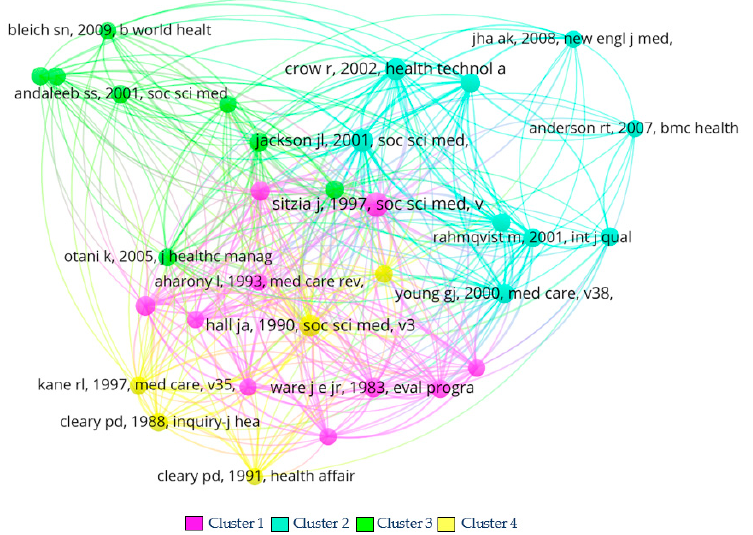
Figure 10. Documents’ co-citation analysis network using VOSviewer software. Source: